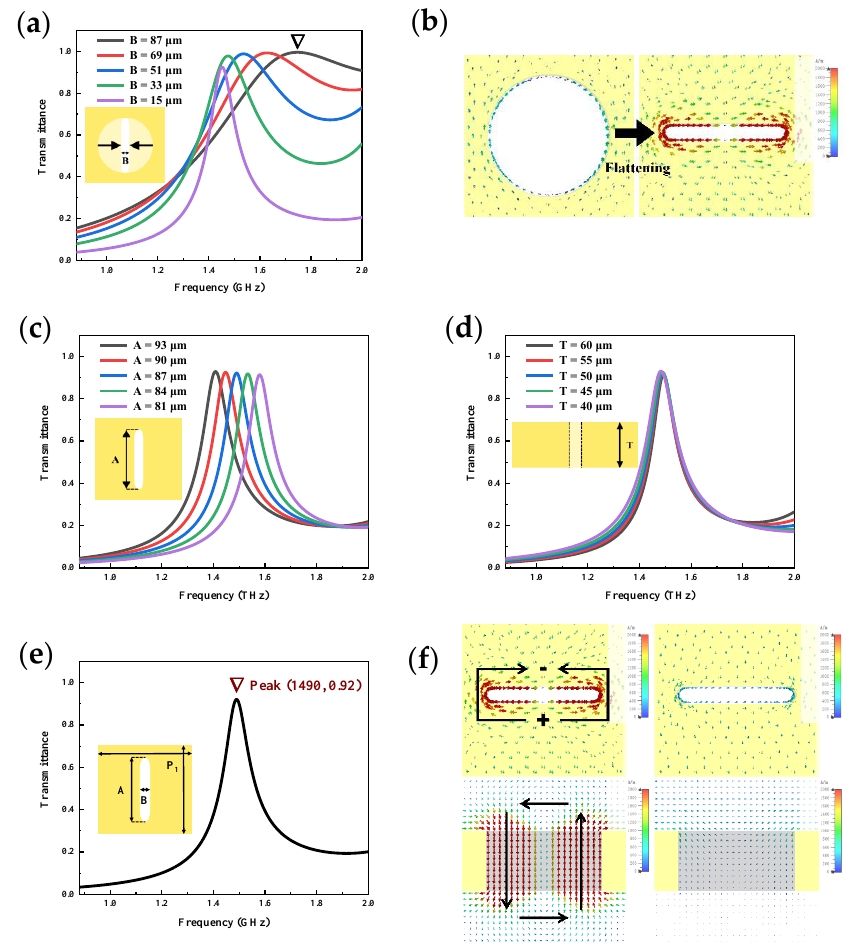
Figure 2. Optimization of MSA metamaterial cell sizes: ( a ) Optimization of slot width (B); ( b ) The variation in surface current after compressing; ( c ) Optimization of slot length (A); ( d ) Optimization of thickness; ( e ) Transmittance of MSA metamaterial simulations; ( f ) Surface currents (above) and magnetic fields (under) at resonant frequencies (1.49 THz) and non-resonant frequencies (0.88 THz).